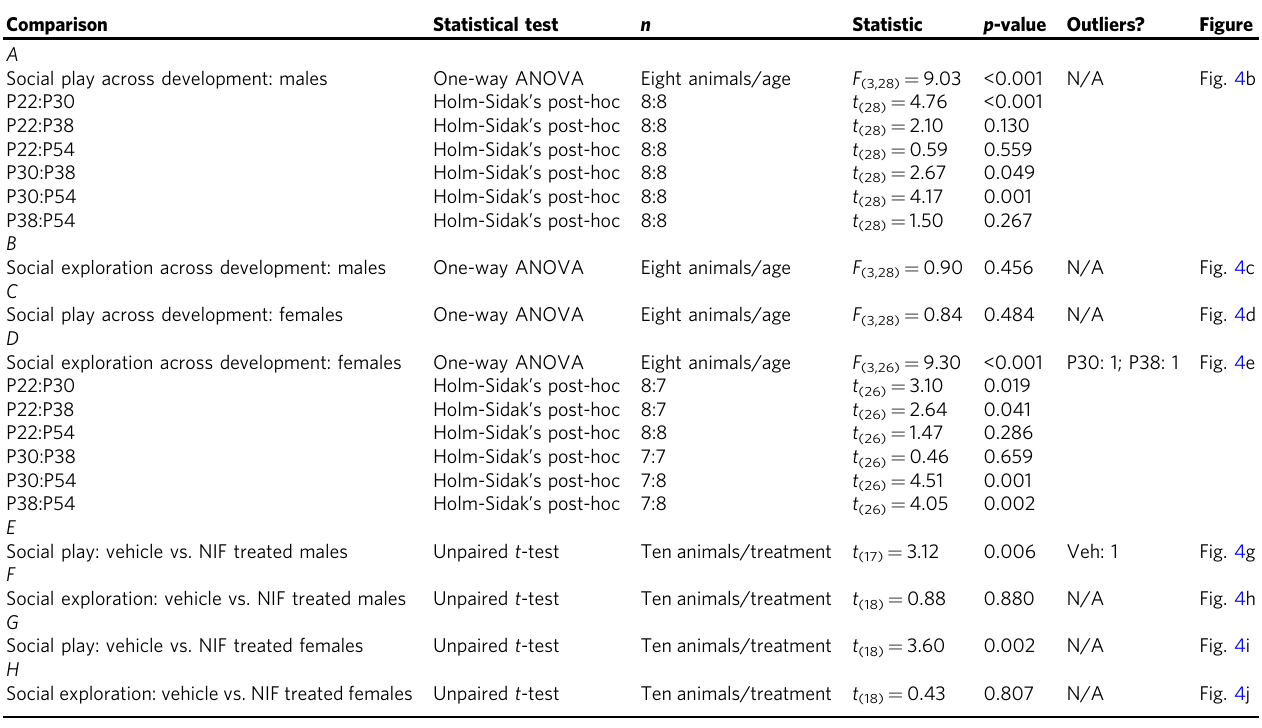
Table 4 Detailed statistics corresponding with Fig.